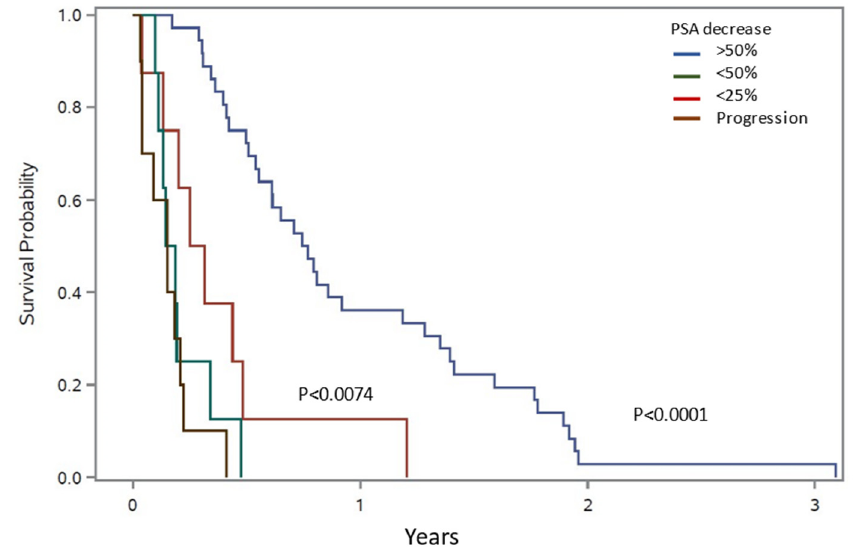
Figure 3. Survival potential (OS) according to different PSA response groups. OS was significantly associated with pre-treatment PSA, MTVtotal, TLAtotal, bone MTV, lymph node MTV and TLA, para-aortic (distant abdominal) lymph node MTV and TLA and number of Lu-treatments (Table 3). PFS was significantly associated with pre- treatment PSA, PSA velocity, MTVtotal and number of Lu-treatments (Table 4). In a mul-